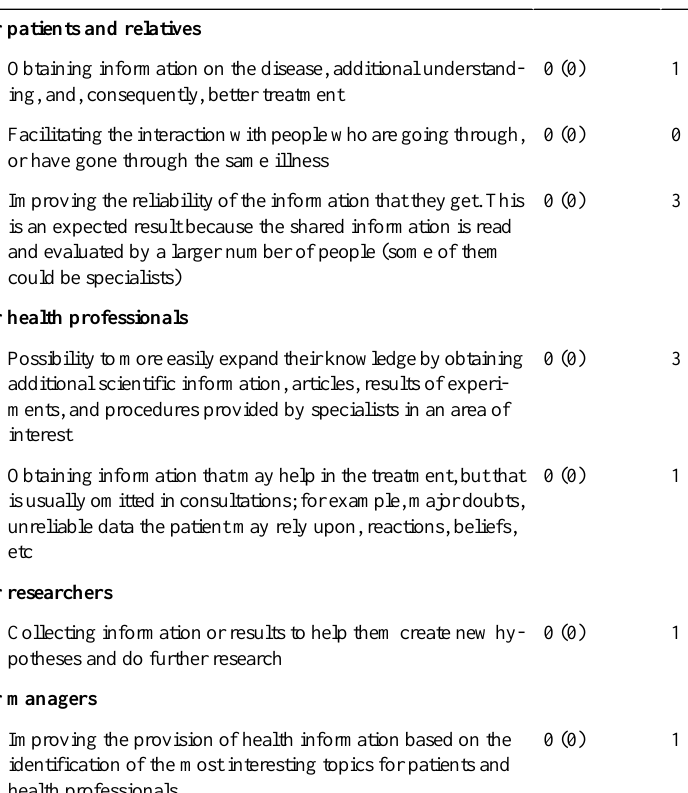
Level of importance, n (%)Activities to be